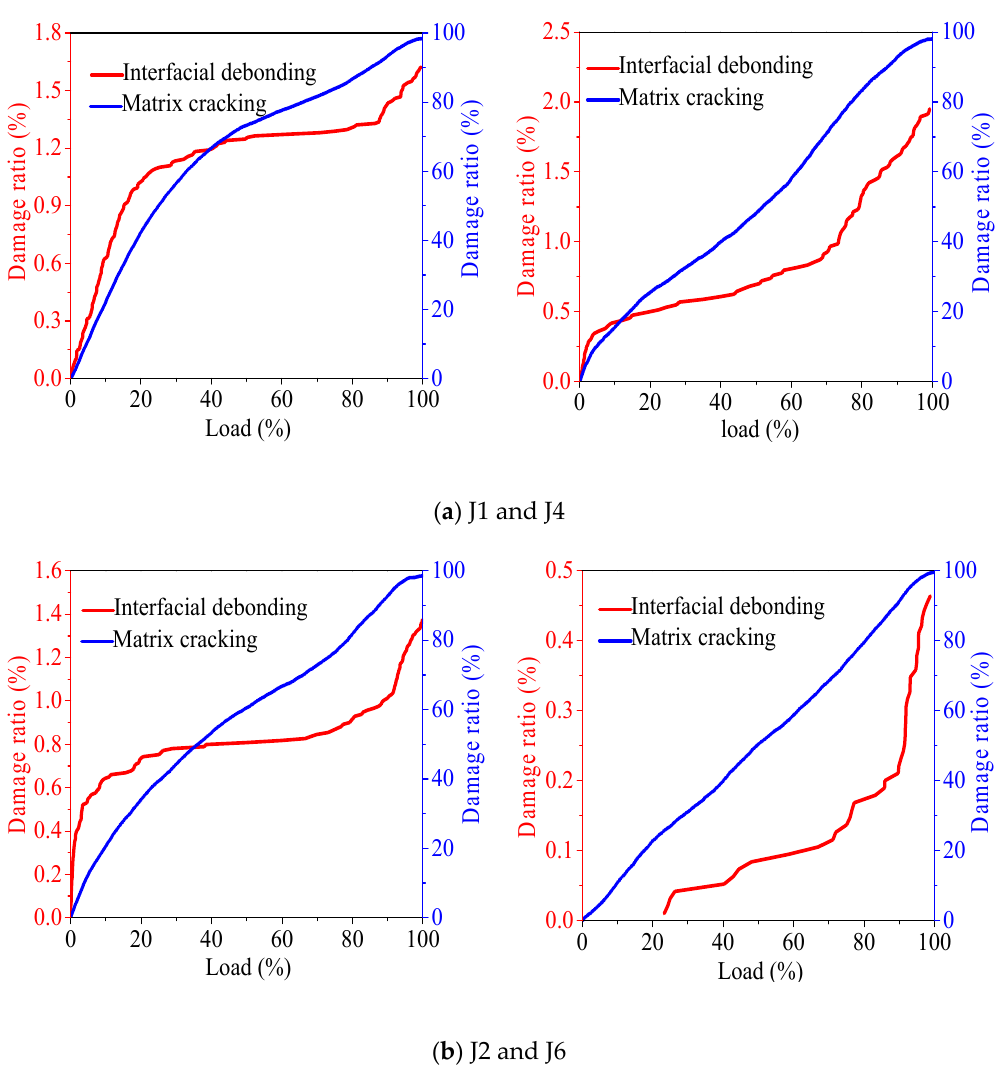
Figure 8. The influence of fine aggregate on the failure state of concrete.